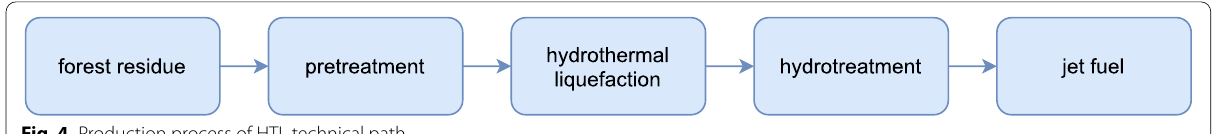
Fig. 4 Production process of HTL technical path